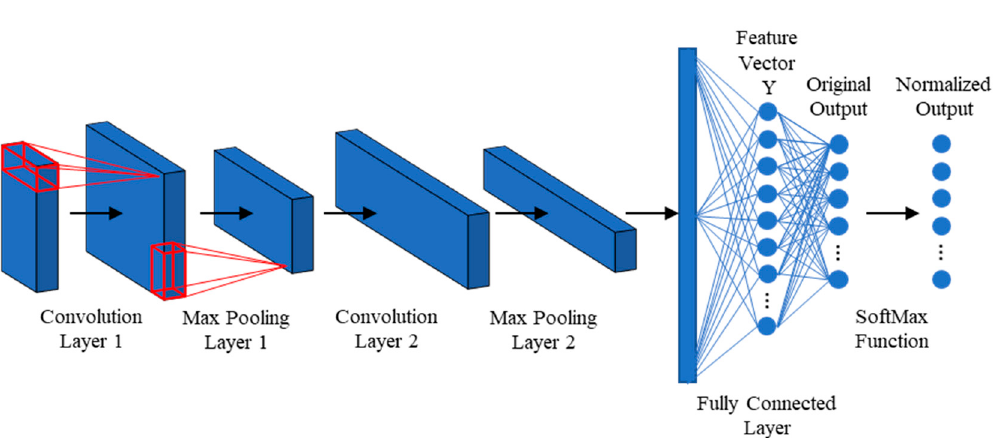
Figure1. Figure 1. The designed structure of the one-dimensional convolutional neural network (1D CNN) model.